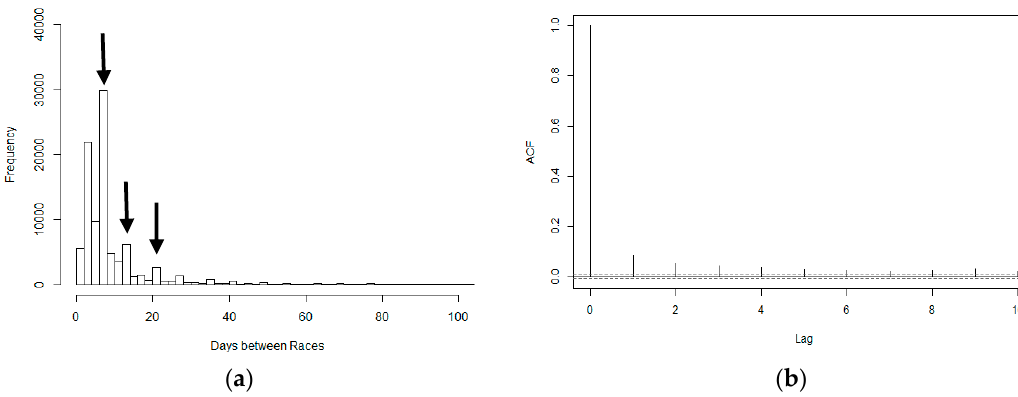
Figure 1. Frequency of racing, in terms of time between racing starts, in a cohort of 2393 racing